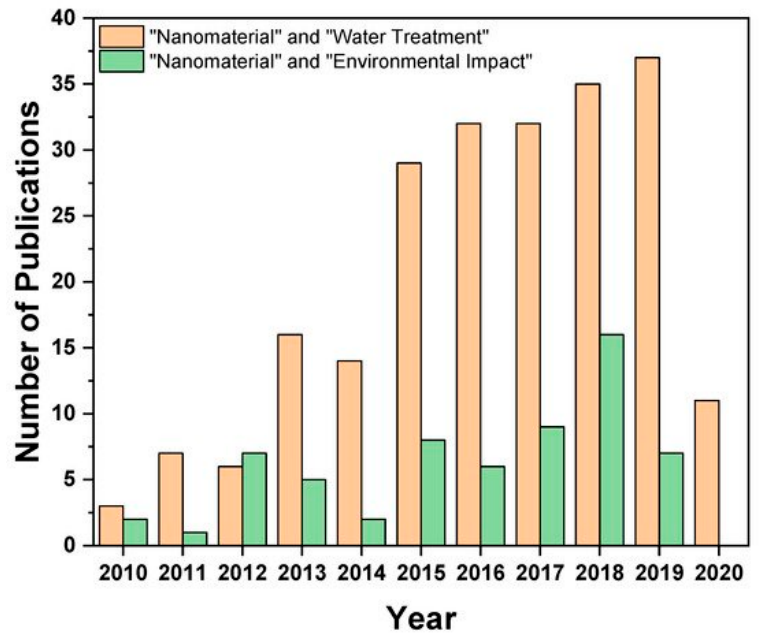
Figure 2. Number of publications in polymer nanocomposites (PNCs) and water treatment. Reproduced with permission from Reference [34]. Open Access 2020, MDPI Water.